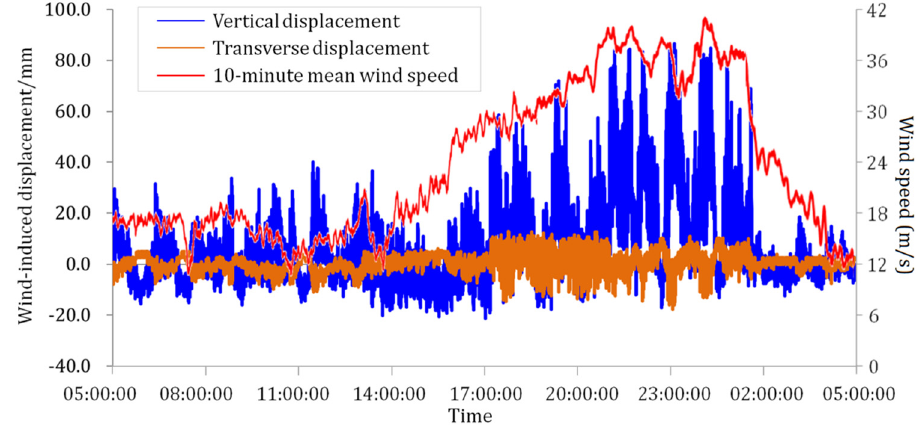
Figure 18: Transverse and vertical absolute displacement to wind speed